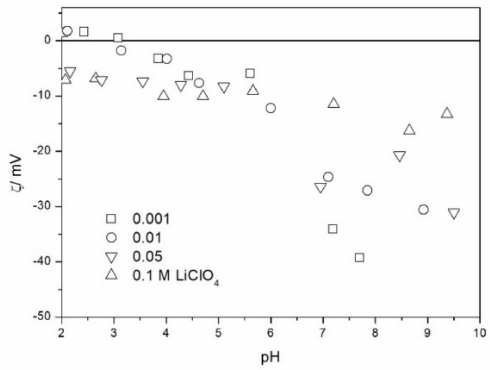
Figure 4. The zeta potential of TeO 2 in LiClO 4 .